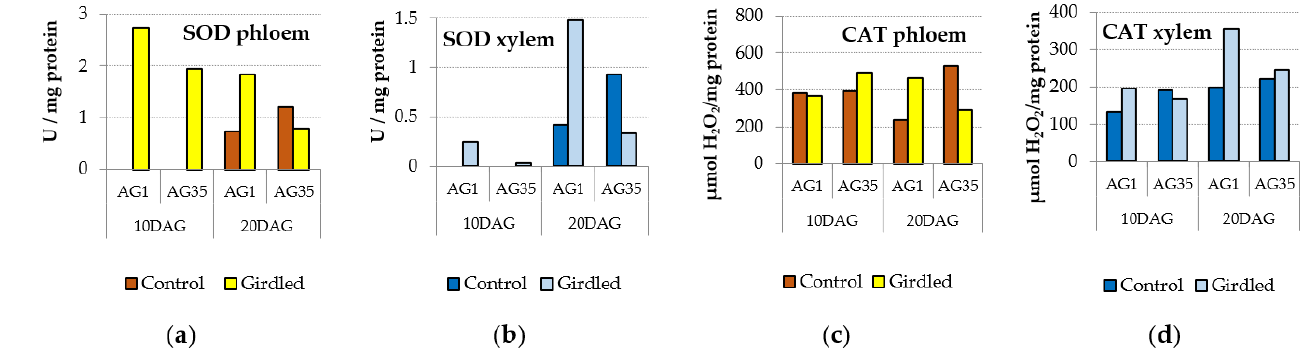
Figure 7. The activity of SOD ( a , b ) and CAT ( c , d ) in phloem ( a , c ) and xylem ( b , d ) of control and girdled trees.